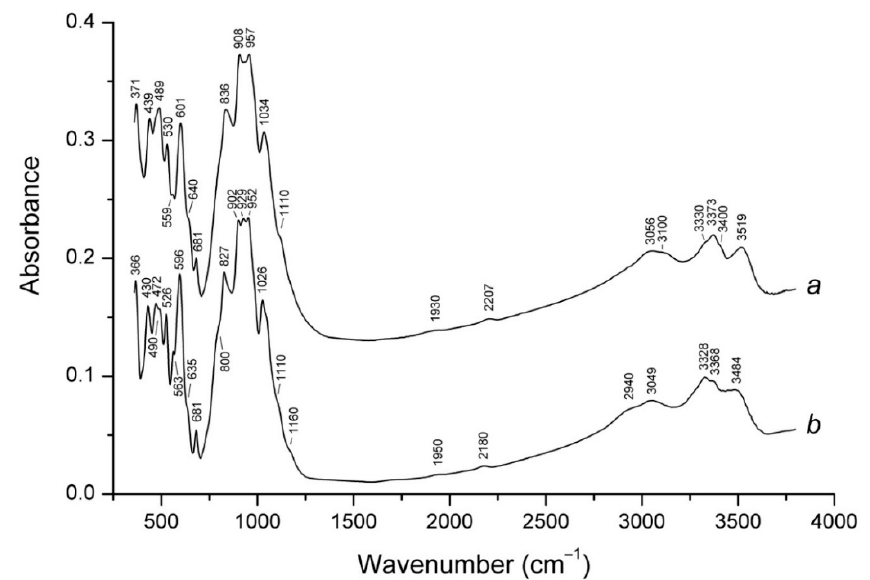
Figure 2. Powder infrared absorption spectra of ( a ) shuiskite-(Mg) from the Biserskoe chromite deposit, Middle Urals, Russia and ( b ) shuiskite-(Cr).